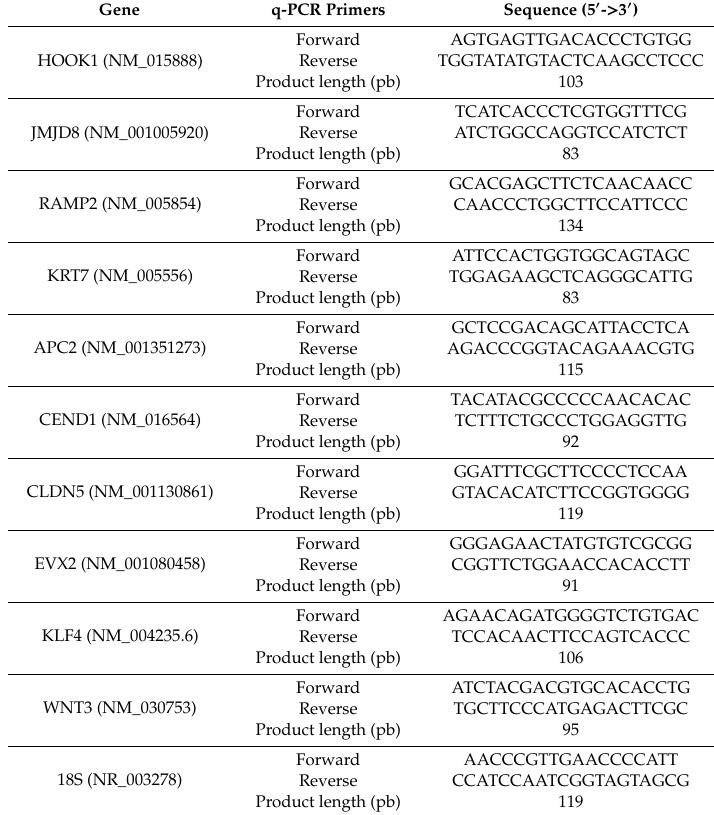
Table A2. Primers used for quantitative PCR (qPCR).